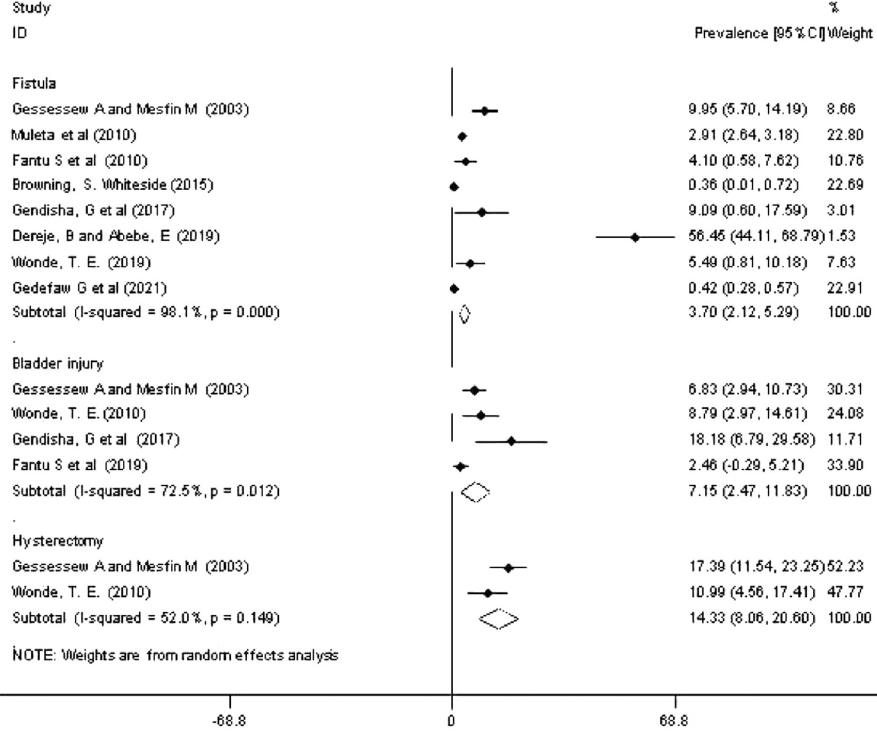
Fig 4. Forest plot of overall prevalence of maternal morbidities outcomes among obstructed labor women in Ethiopia, 2021.